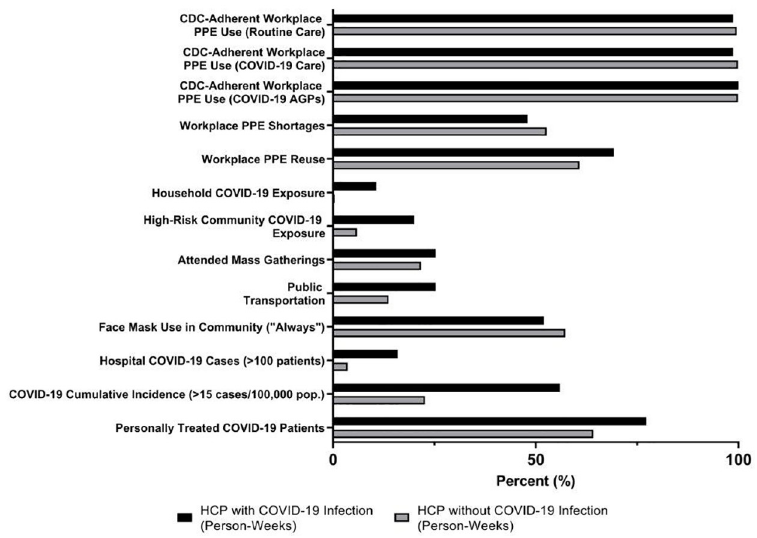
Fig 2. Occupational and community COVID-19 infection risk in emergency department health care personnel, United States, May–December 2020. This graph shows the percentage of participant epochs with each of the a priori- defined risk factors. Risk factor definitions are summarized in S1 Table. CDC , Centers for Disease Control and Prevention , CDC; AGP , aerosol-generating procedures; PPE , personal protective equipment; HCP , health care personnel